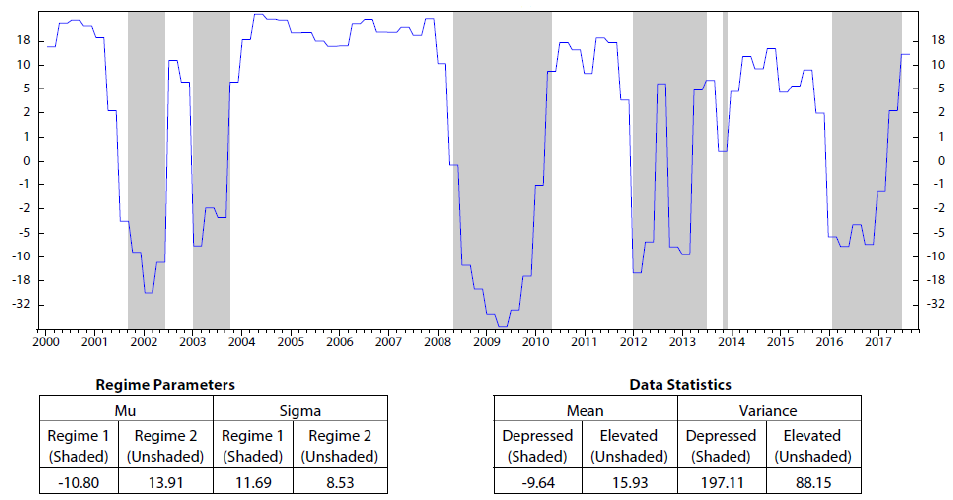
Figure A3. The world sentiment and its regimes detected using HMM for monthly data from 31 December 1999 to 31 August 2017. Regime 1 and regime 2 correspond to the depressed and elevated periods of the world sentiment, respectively.